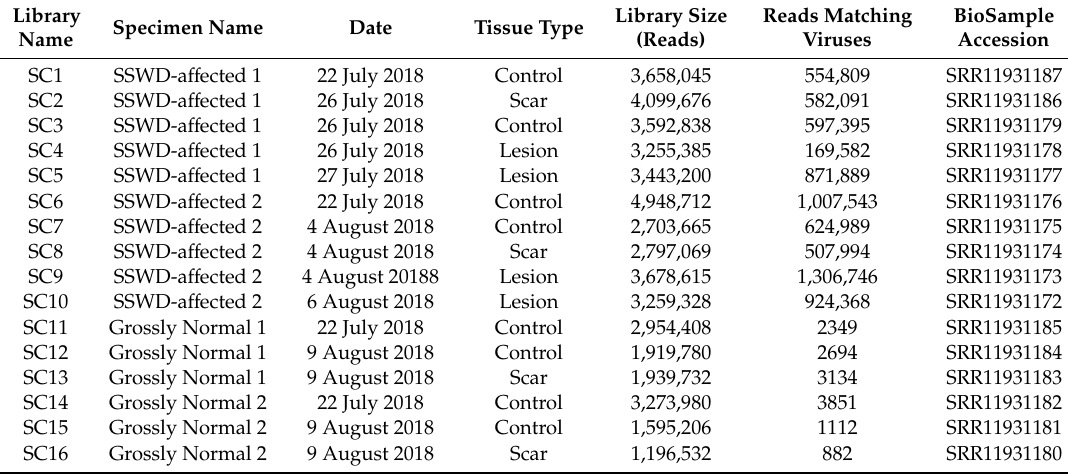
Table 1. Viral metagenomics library characteristics for Pisaster ochraceus wasting temporal